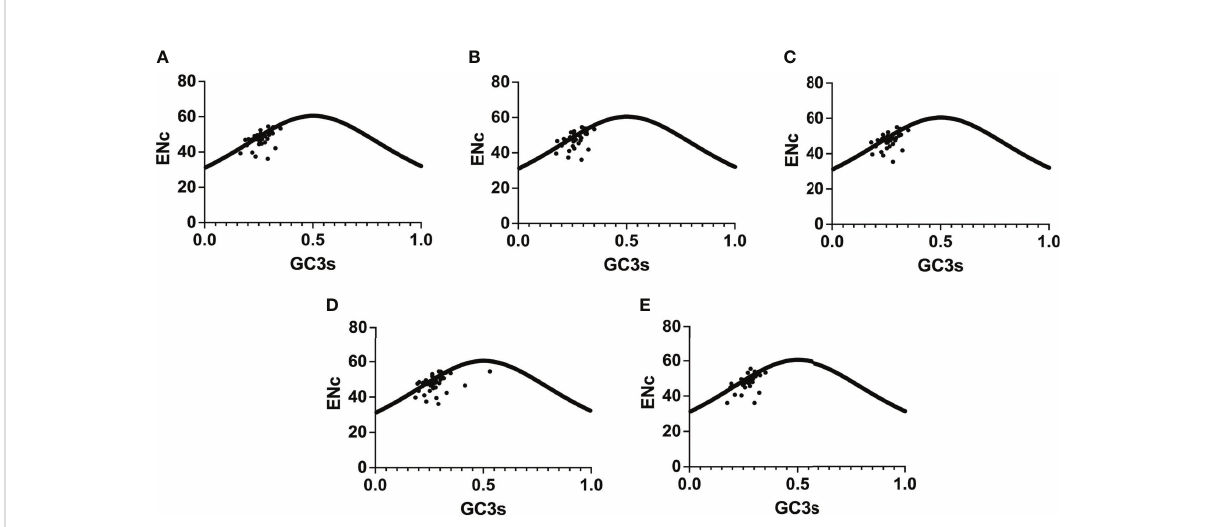
FIGURE 8 ENc-plot analysis for Phlomis fruticosa and four Phlomoides species. From (A – E) are the ENc-plot analysis of Phlomoides alpina, Phlomoides betonicoides, Phlomoides younghushandii, Phlomoides strigosa, and Phlomis fruticosa. If the point in the fi gure falls near the curve, it indicates that the actual value of ENc is close to the expected value. On the surface, its codon bias is mainly affected by base mutation. If the point falls away from the curve, it indicates that base mutation is not the main factor affecting its codon preference.